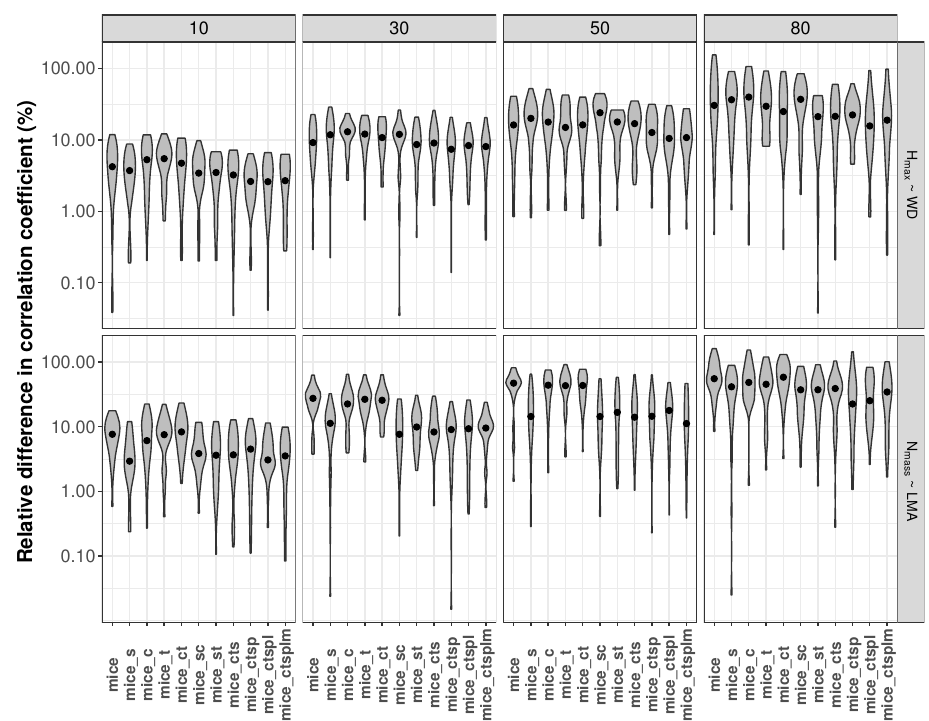
Figure 5. Errors in the correlation coefficient for two selected trait relationships at increasing missingness levels (10–80%) and for different MICE imputations using different combinations of additional predictor sets: species identity ( s ), climate ( c ), forest structure ( t ), topogra- phy ( p ), lithology ( l ) and sampling month ( m ). See Fig. 1 for an overall view of the experimental design and the methods section for a detailed description of the variables employed in each predictor set. Note that the y axis is in the logarithmic scale. Traits involved in the relationships are leaf nitrogen per unit mass, N mass (%mass); maximum tree height, H max (m); leaf mass per area, LMA (mgcm − 2 ); wood density, WD (gmcm − 3